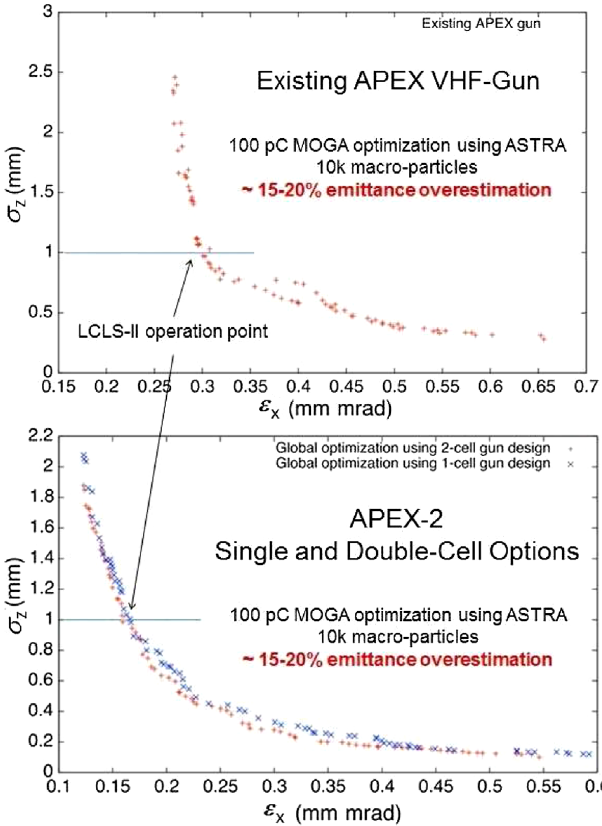
FIG. 5. Fronts of 100 pC solutions illustrating the trade-off between emittance (100% of particles included) and rms bunch length at the end of the injector. Top: Present APEX VHF-gun case. Bottom: The fronts for the cases of the double cell and single cell with no drift tube APEX-2 configurations described in the